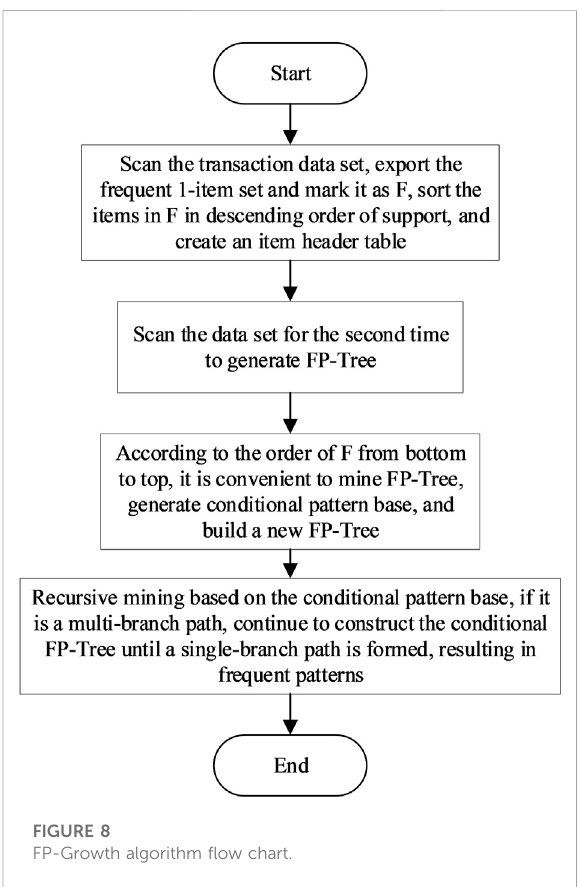
FIGURE 8 FP-Growth algorithm fl ow chart.